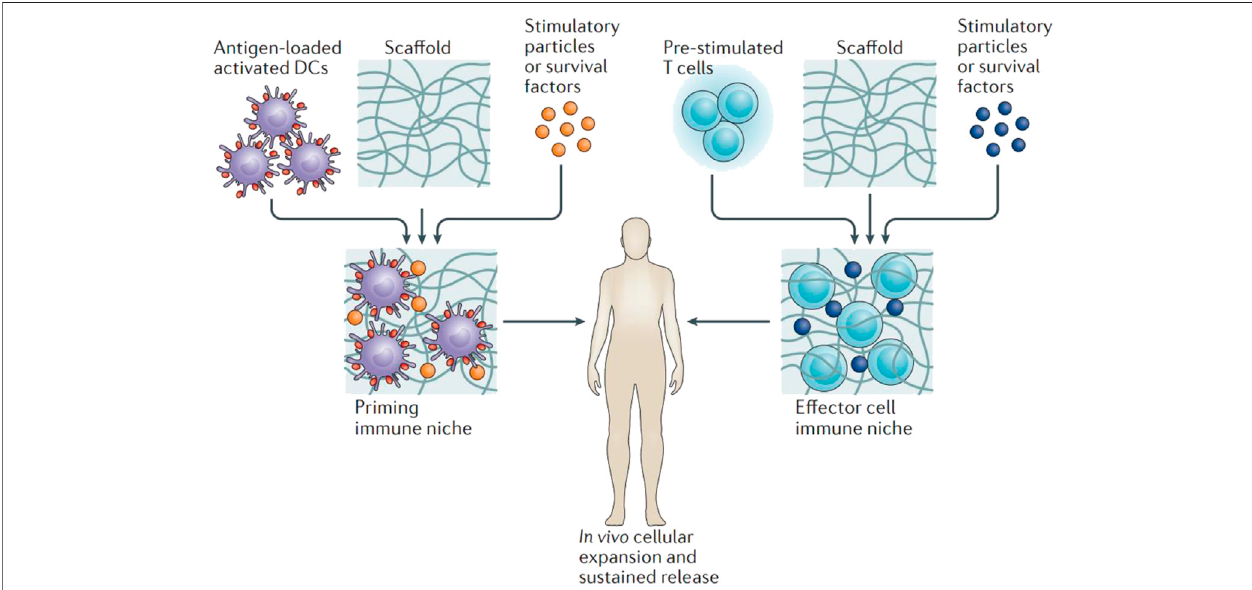
FIGURE 4 | Hydrogels applied in the delivery of immune cells. Antigen-loaded activated dendritic cells or pre-stimulated tumour-speci fi c T cells are loaded to hydrogelscaffolds exvivo .Stimulatoryagentswereencapsulatedtosupportcellsurvival,activationandexpansion.Afteradministrationofthematrixclosetothetumour site, potent immune cells proliferate within the scaffold and are released continuously into the tissue environment. Reproduced with permission Weiden et al. (2018). Copyright 2018